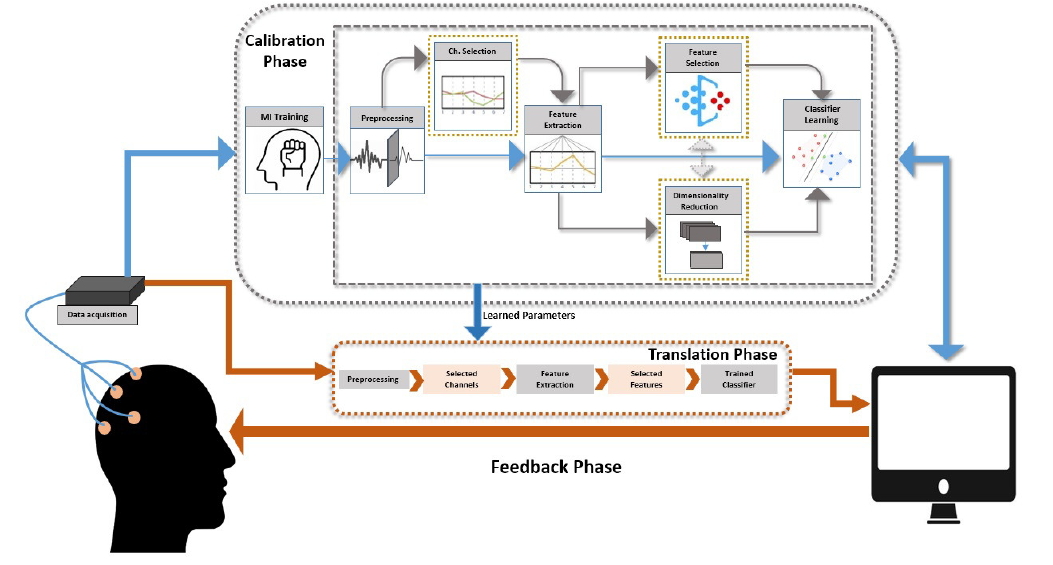
Figure 2. Block diagram showing the typical structure of MI-based brain–computer interface (BCI).